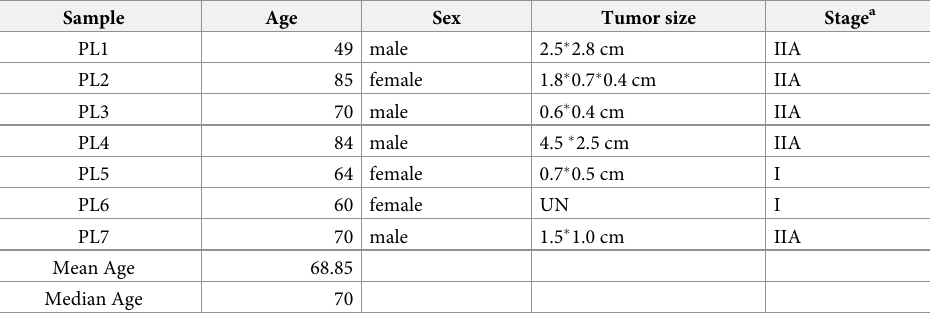
Table 1. Clinicopathological features of PDAC patients included in the